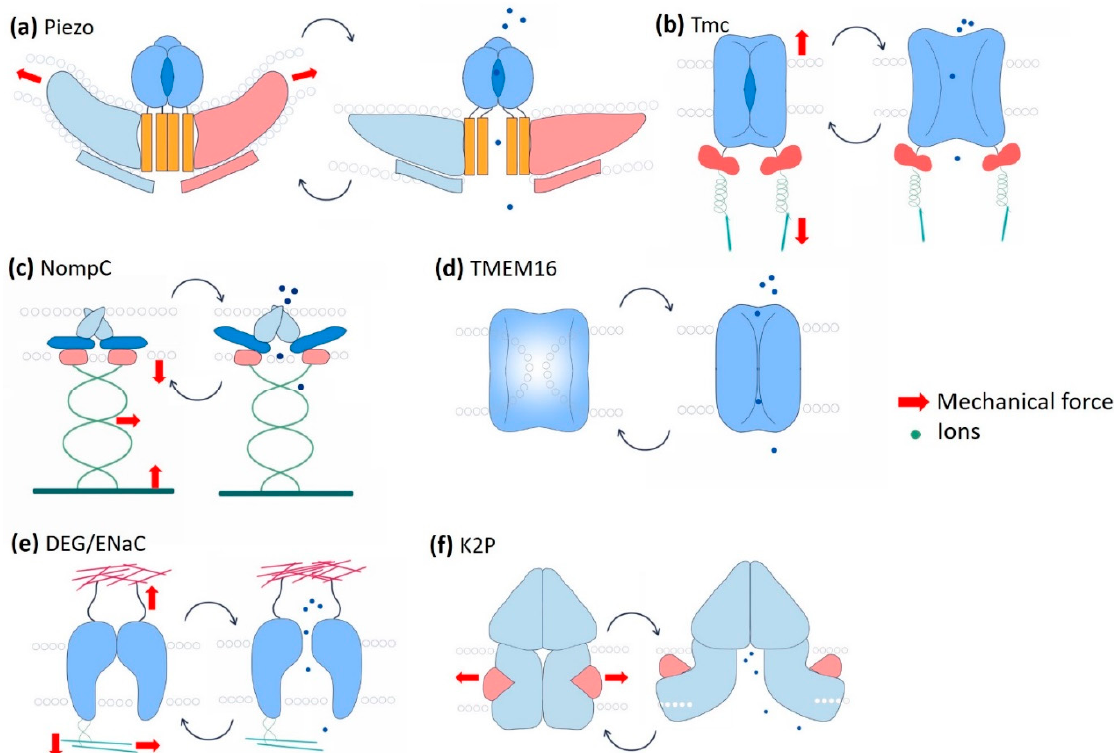
Figure 3. Schematic representation of mechano-gated channels and their gating mechanisms. ( a ) The Piezo channel is supposed to form a caveolae-like depression in the membrane. It is directly gated by membrane tension. Directional membrane tension flattens the channel to allow Ca 2+ influx. ( b ) The transmembrane Channel-like Protein (Tmc channel) forms complexes with a group of other proteins that bring extracellular mechanical inputs. Intracellular Tmc is connected to the cytoskeleton by ankyrin and calcium-binding proteins. The channel is gated via the tension mediated by the tethering proteins from both extra and intracellular interfaces. ( c ) No Mechanoreceptor Potential C (NompC) has a substantially long (29 ankyrin repeats) cytoplasmic domain that interacts with the microtubules. The gating of NompC depends on the deflections of the ankyrin repeat helices mediated by the cytoskeleton components. ( d ) Transmembrane protein 16 (TMEM16) is a calcium-dependent chloride channel (CaCC). The dual function of TMEM16 as a lipid scramblase and as an ion channel makes it unique. These two functions are mutually exclusive and depend on the membrane tension-mediated conformational change of the protein. ( e ) The epithelial sodium channel (ENaC) interacts with both extracellular and intracellular proteins. Hydrostatic pressure, membrane stretch, and shear forces are the key mechanical cues that determine the gating of the channel pore. ( f ) The two pore domain K + channel (K2P), in its closed state, is blocked by the lipid. Membrane tension releases the lipid blockade and allows the hinge-like bending of the transmembrane domain and eventually ion